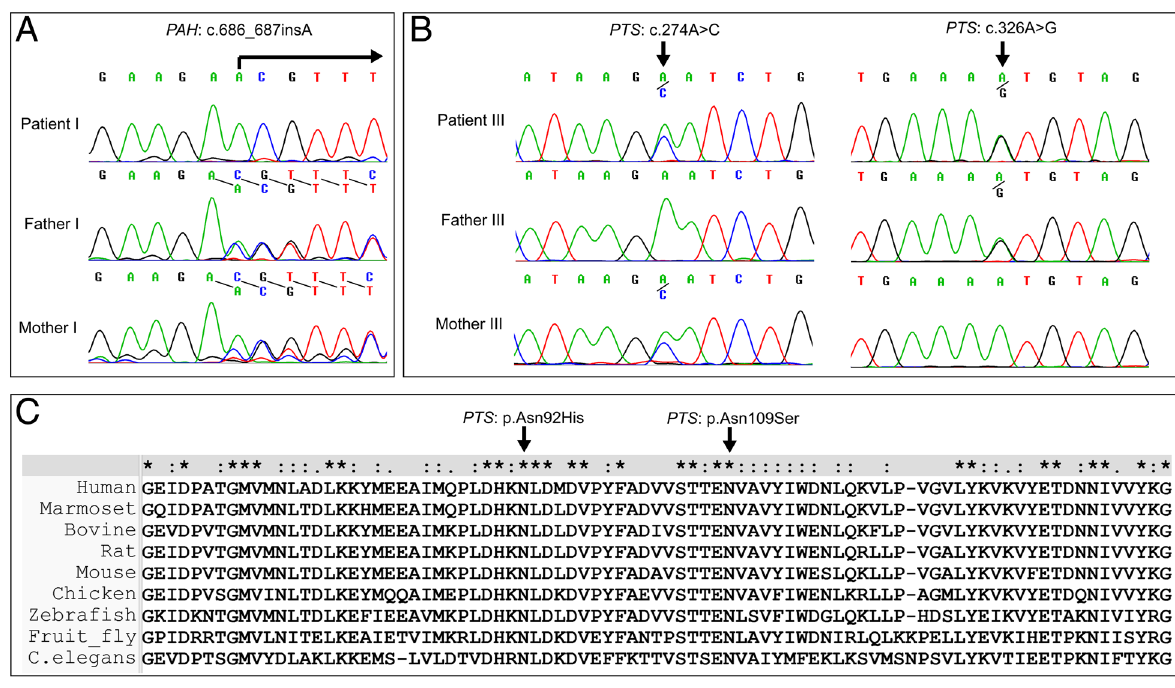
Fig. 1 Chromatogram of novel mutations in Patient I ( a ) and Patient III ( b ) and amino acid conservation for novel missense mutations in Patient III ( c